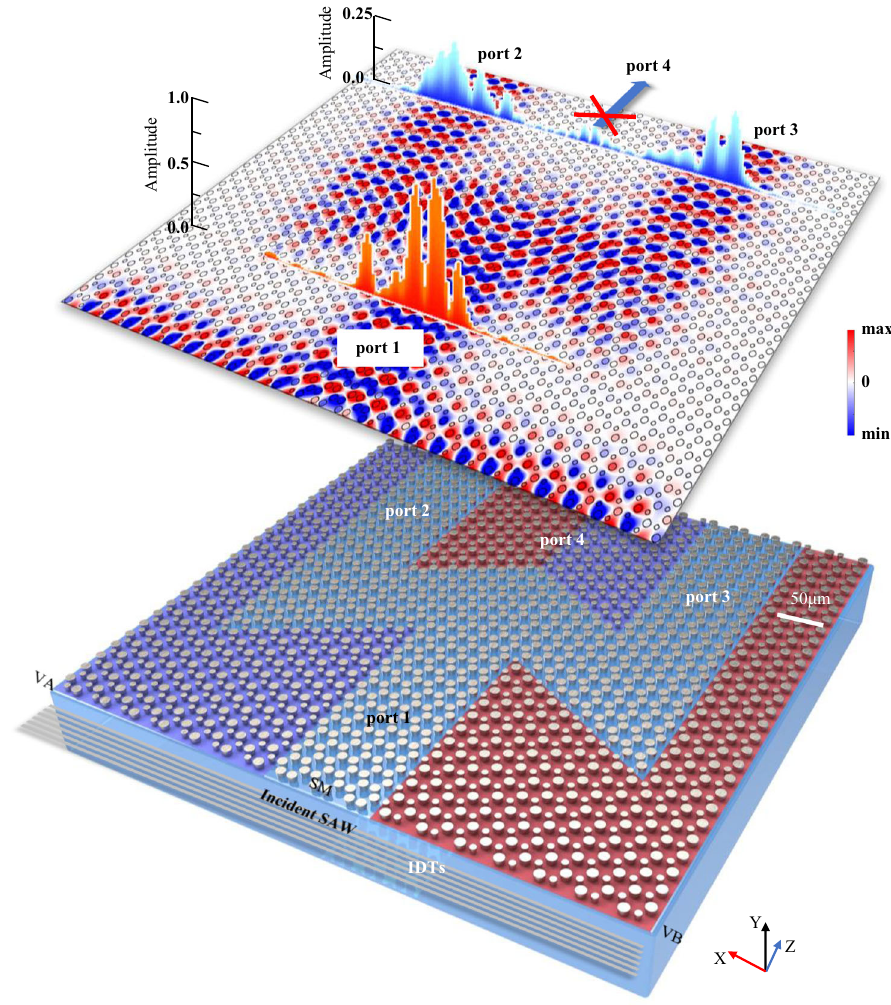
Fig. 3 High throughput SAW splitter based on the ETVS. (bottom) Schematic of a three-ports SAW splitter sample consists of the (blue shaded) VA, (red shaded) VB, and (unshaded) SM. In the experiment, planar SAWs are injected into the sample from Port#1 and captured from the other three ports. (upper) Calculated SAW out-of-plane displacement distributions and experimentally imaged SAW amplitude around all four ports. All SAWs are highly localized in routes that hold the same valley pseudospin, i.e ., the SAWs are output the sample only via Ports #2 and